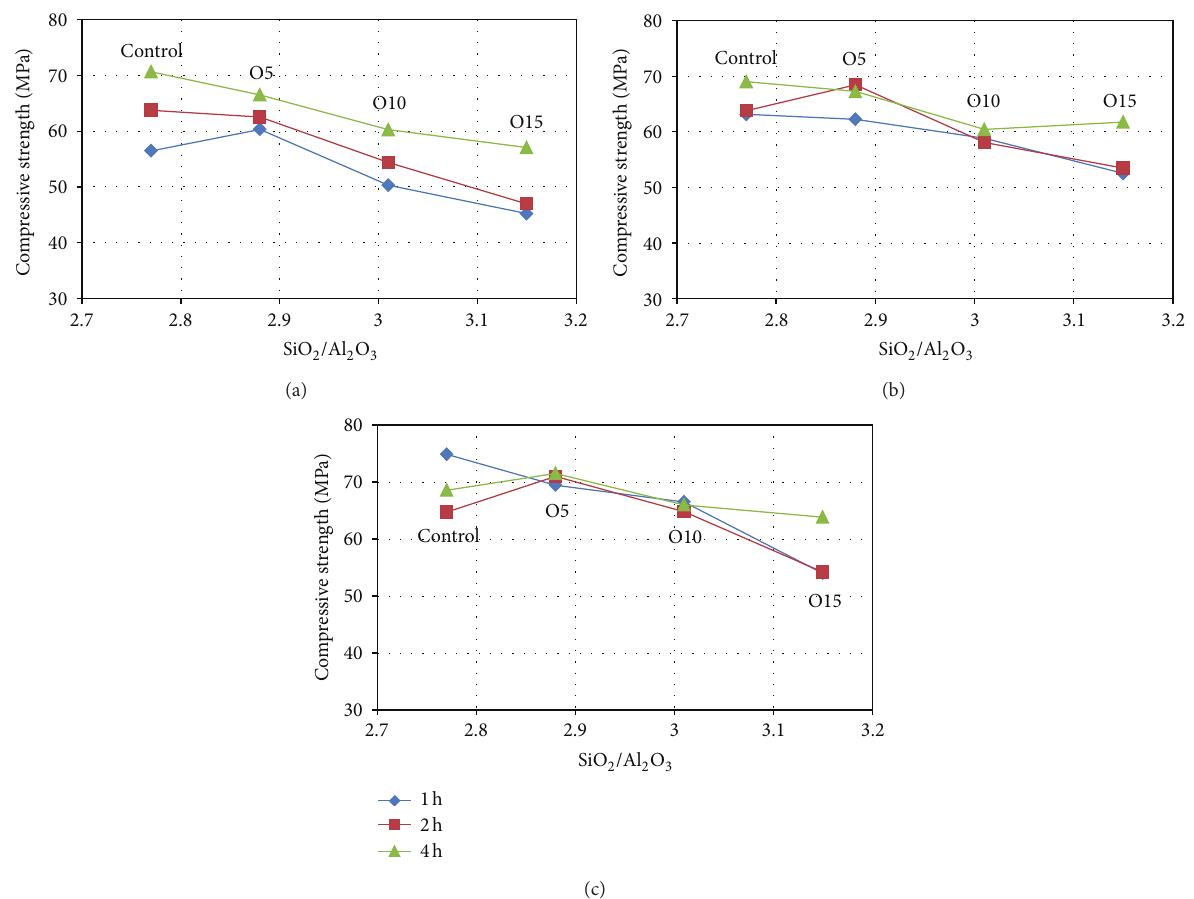
Figure 3: Compressive strength of geopolymer mortar with different SiO 2 /Al 2 O 3 and heat curing time measured after (a) 2 hours, (b) 24 hours, and (c) 28